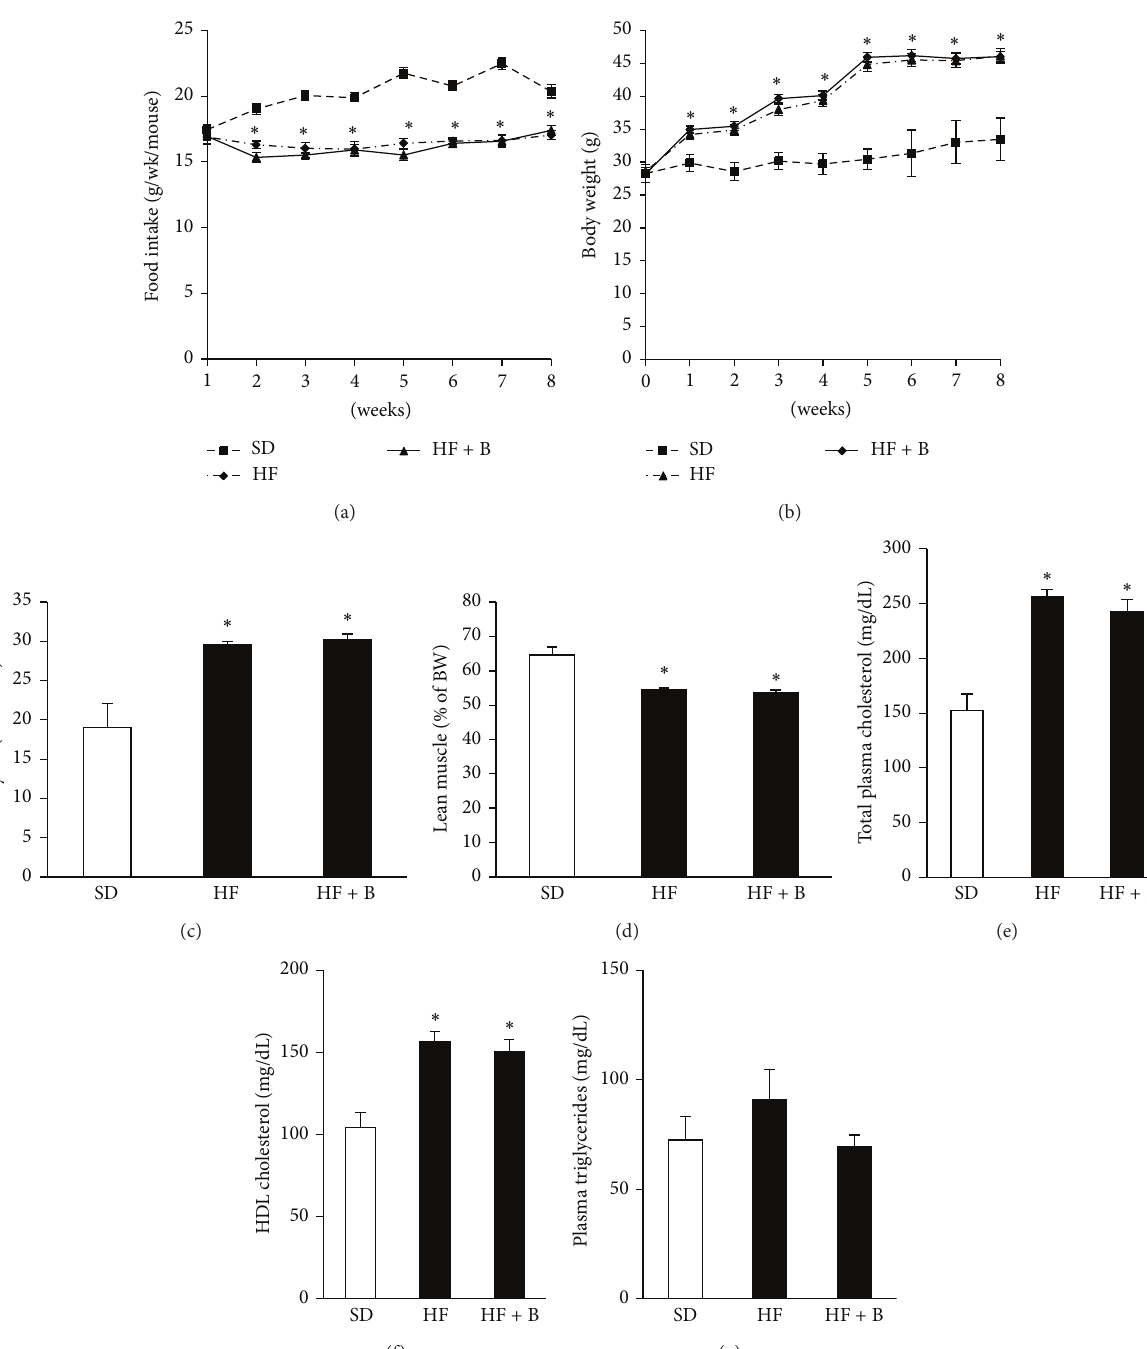
Figure 1: Baicalein supplementation had no effects on food consumption, BW, body composition, or the plasma lipid profile in HF diet- induced obese mice. C57BL/6 male, retired breeder (8mo) mice were used for this study. Food intake was recorded every 2 or 3 days and cumulative weekly food consumption was calculated (a). BW was monitored every wk (b). Body composition during the final week of the trial was measured with fat tissue mass (c) and lean mass (d) expressed as a percentage of the BW. At the end of the 8th wk of the experiment, fasting plasma total cholesterol (e), HDL-cholesterol (f), and triglycerides (g) were measured. Values represent mean ± SE ( 𝑛 = 10 /group). ∗ 𝑃 < 0.05 versus SD group. BW: body weight, SD: standard diet, HF: high-fat diet, and HF + B: HF + 0.5 g baicalein/kg